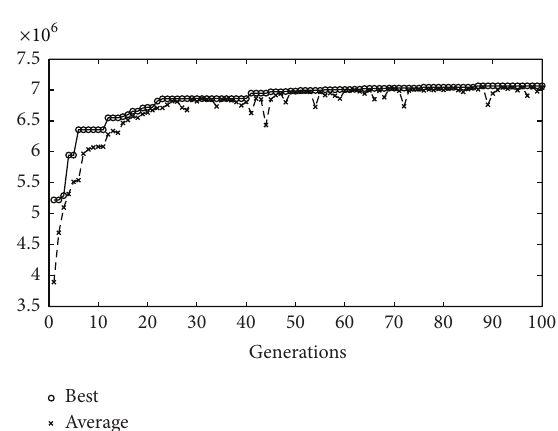
Figure 5: Convergence of fitness in GAFMRAC.